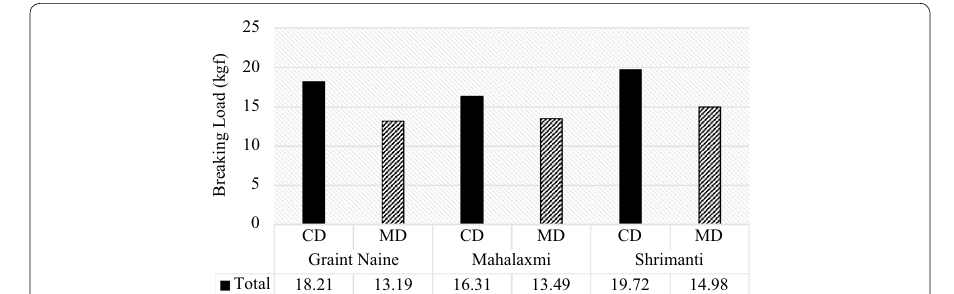
Fig. 5 Tensile strength of cross laid (60:40) banana nonwoven fabric